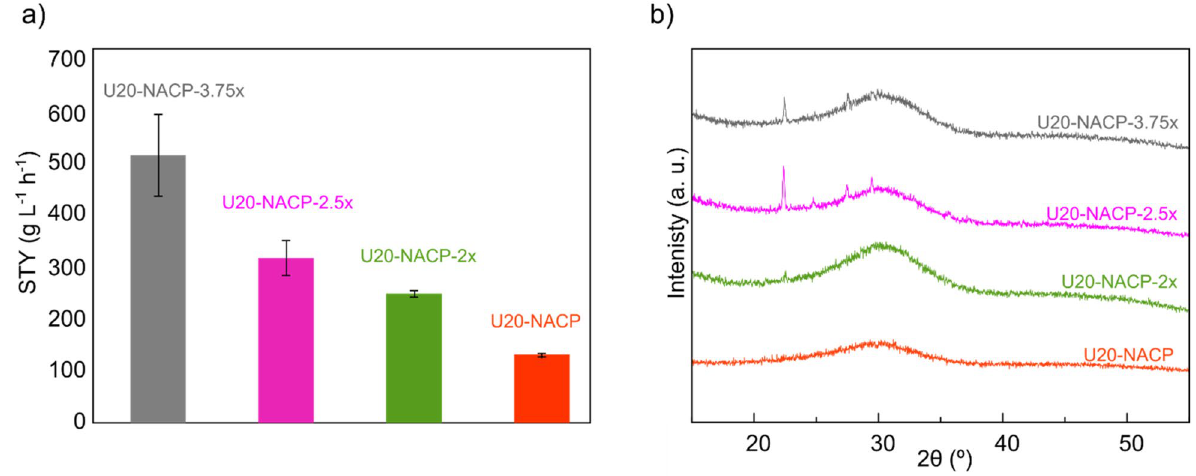
Figure 2. ( a ) Space–time yield of the reaction (STY) calculated for U20-NACP-3.75x, U20-NACP-2.5x, U20- NACP-2 × and U20-NACP. Data are expressed as mean (n = 3) with the corresponding standard error shown as error bars. ( b ) XRPD patterns of the hybrid materials. The characteristic reflections of urea, falling at 2θ = 22.4°, 24.6° and 29.3°, can be appreciated for the materials obtained by increasing the concentration of reagents 2.5 x, or higher than in the preparation of